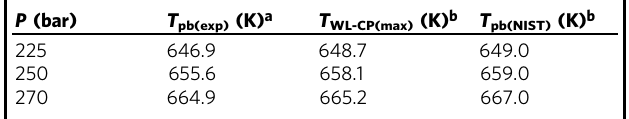
a The accuracy of the temperature measurement is ±1.5K (see the “ Methods ” section) b The temperatures corresponding to the Widom line of maxima isobaric heat capacity 13,26 and the pseudo -boiling temperatures according to Banuti ’ s theory